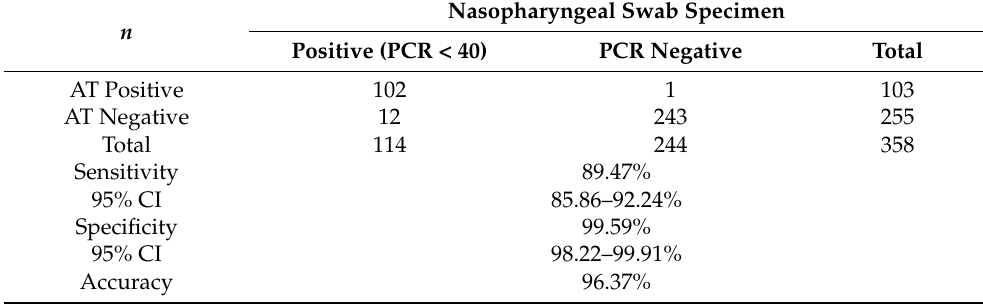
Table 3. Test results and analysis of nasopharyngeal swab specimens with Ct values of PCR positivity less than